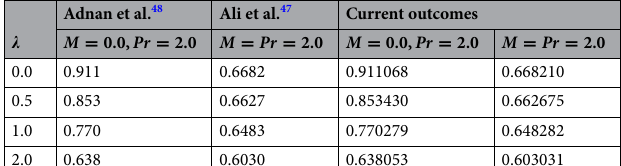
1.0 subject to no effect of others